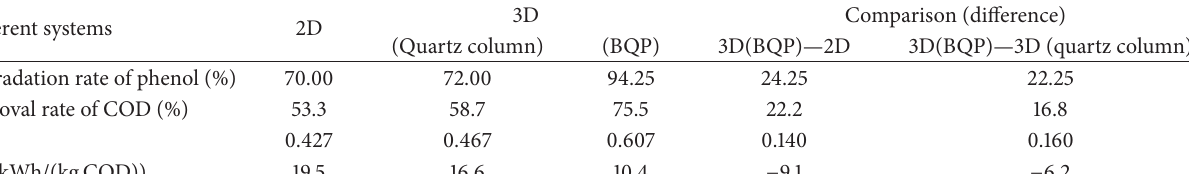
Table 2: Comparison of different systems.